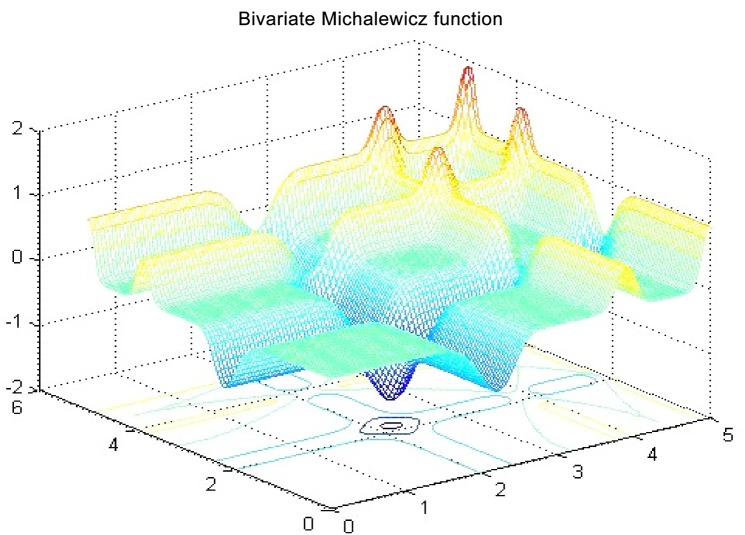
F5 function in 2D for m = 10, n = 5.